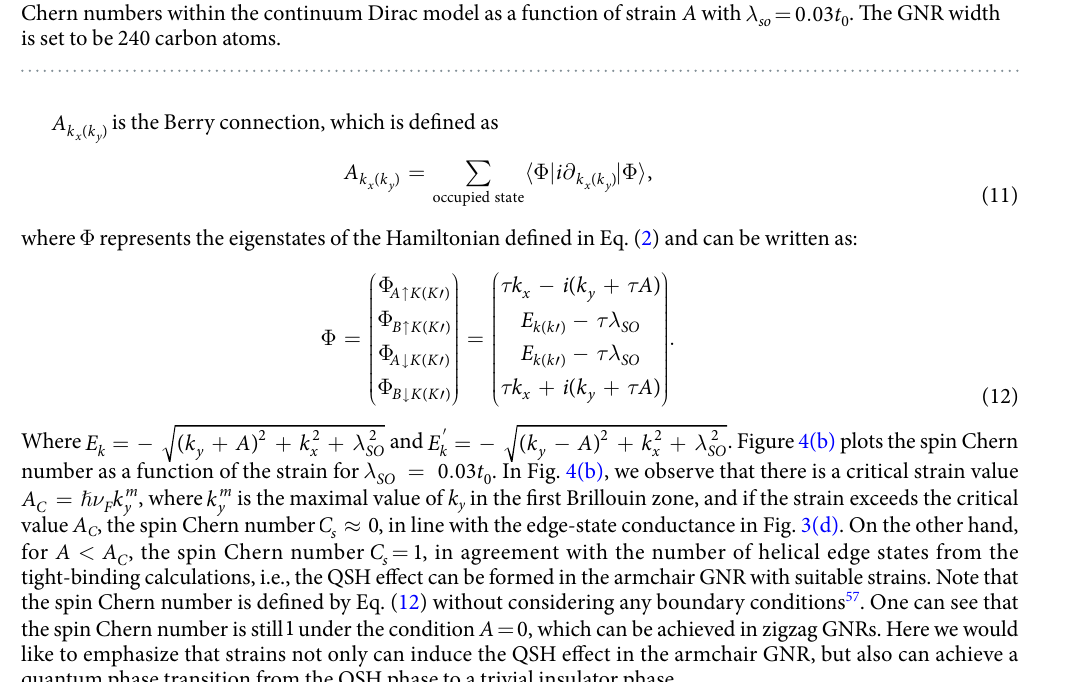
. The GNR width so 0